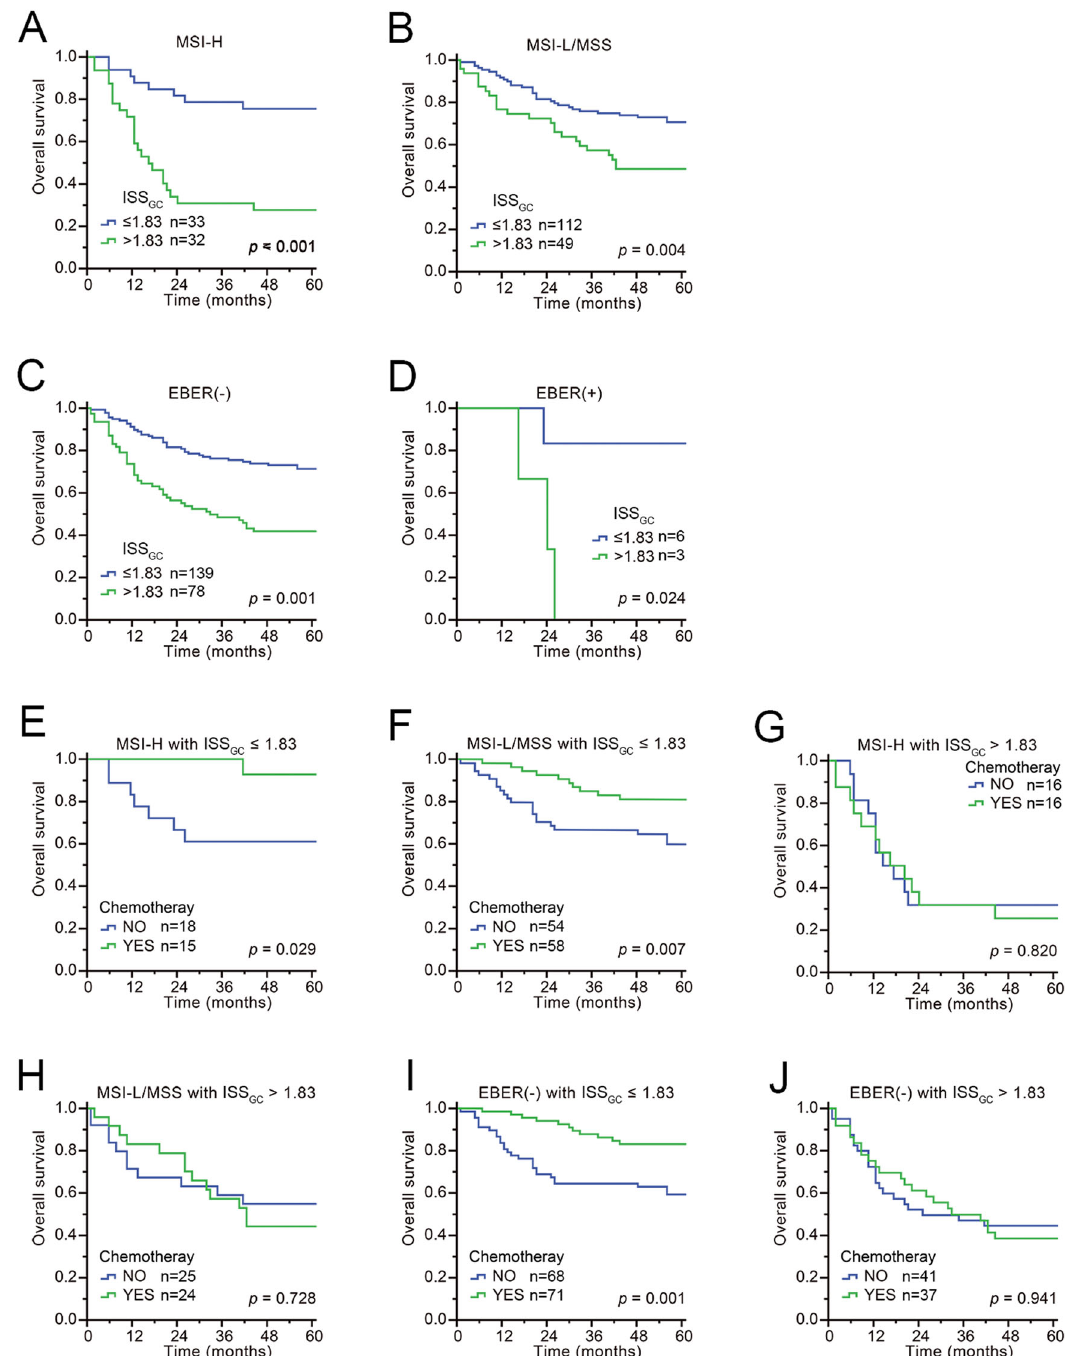
Fig. 8 External validation. Prognostic value of ISS GC score on gastric cancer patients and receipt of adjuvant chemotherapy strati fi ed by their MSI or EBV status. A , B Overall survival based on MSI status in GC patients after ISS GC strati fi cation is presented using Kaplan – Meier curves. C , D Overall survival based on EBV status in GC patients after ISS GC strati fi cation is presented using Kaplan – Meier curves. E – H Overall survival analysis of chemotherapy based on MSI status in GC patients after ISS GC strati fi cation is presented using Kaplan – Meier curves. I , J Overall survival analysis of chemotherapy in EBV-negative GC patients after ISS GC strati fi cation is presented using Kaplan – Meier curves. p -Values for survival analyses have been calculated using the log-rank